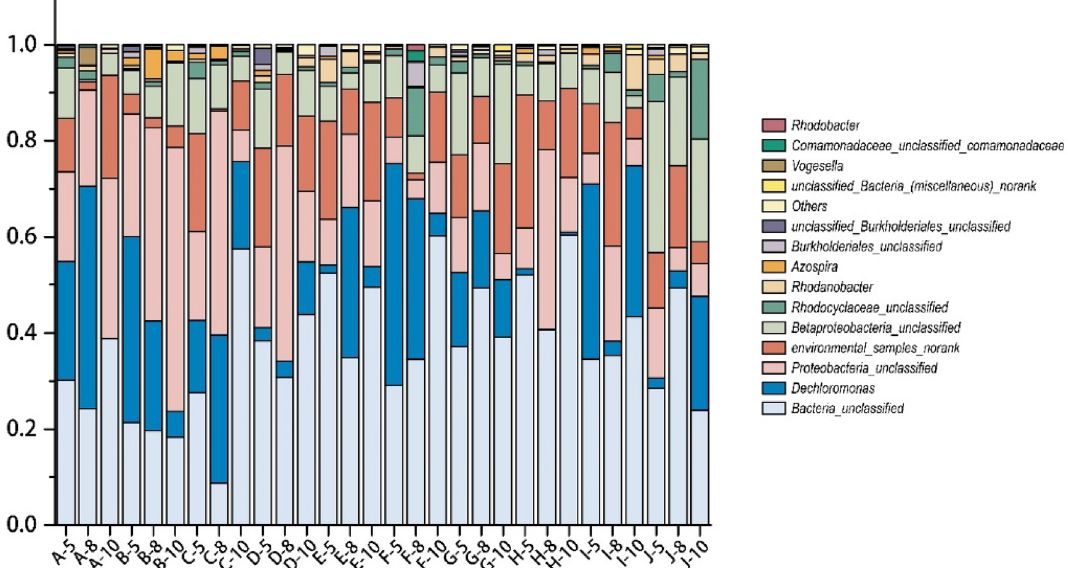
Figure 3. Community structure of the surface-flow constructed wetland in each